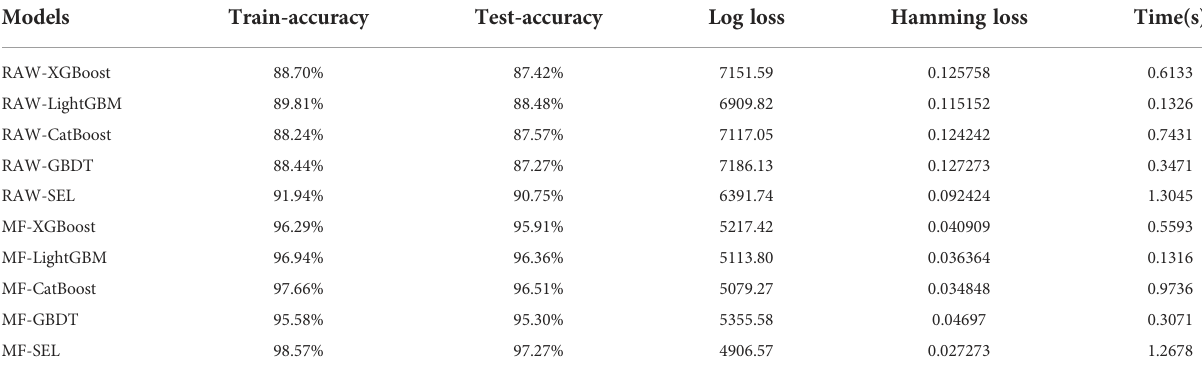
TABLE 2 Evaluation indicators of MF combined with fi ve classi fi cation models for the classi fi cation results of peanut seed samples. Models